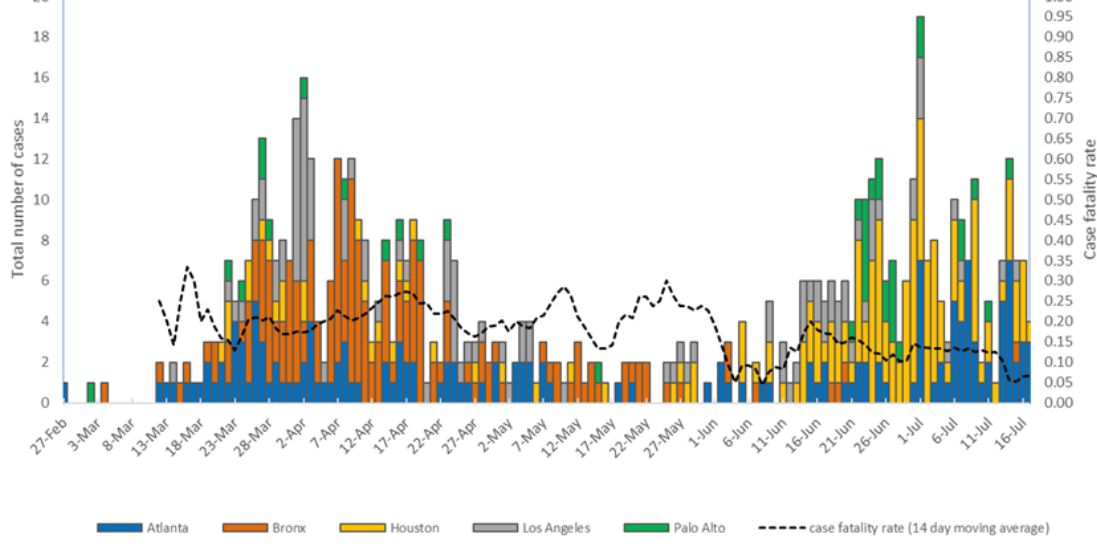
Figure 1. Epidemic curve of hospitalized COVID-19 cases and case fatality rate for US veterans at 5 Veterans Affairs Medical Centers by hospital admission date, from February 27 to July 17, 2020. Case fatality rate represents a 14-day moving average. Rate suppressed prior to March 12, 2020, due to low case counts (n ≤